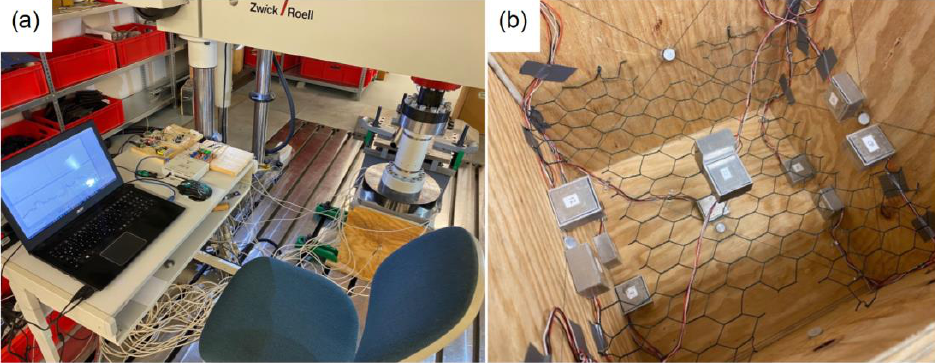
Figure 4. ( a ) Measuring station at the ZWICK HB 160 testing machine, ( b ) Interior view of the test box.